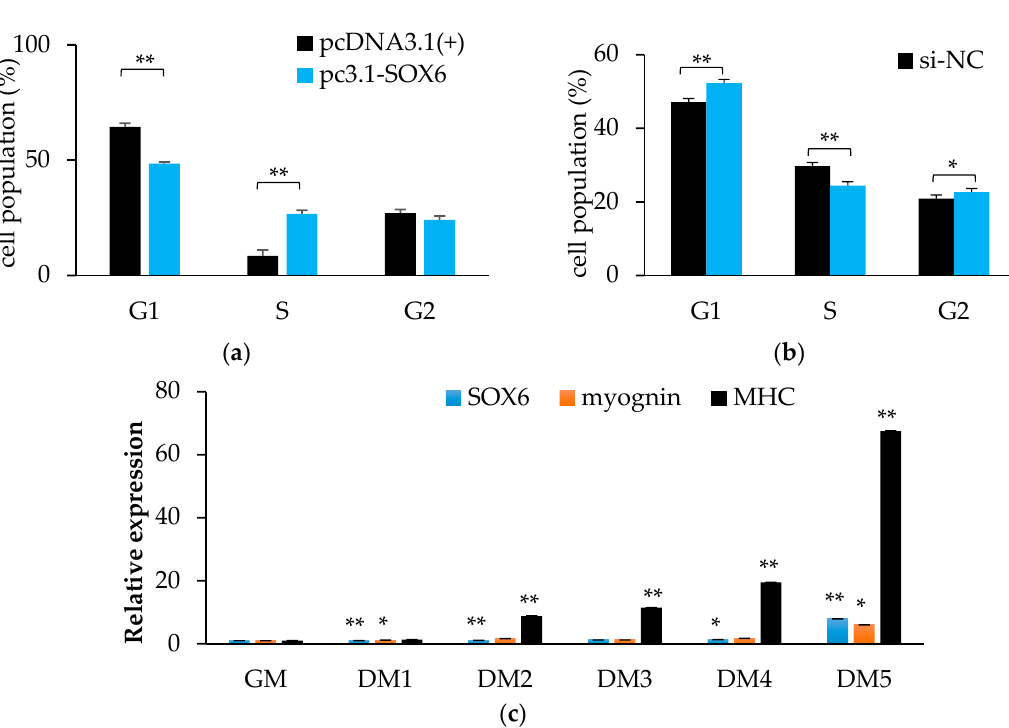
Figure 8. Chicken SOX6 promotes cell proliferation and differentiation. ( a , b ) The cell population of cell cycles after overexpressing or interference with SOX6, respectively. ( c ) The expression levels of SOX6, myognin and MHC in QM7 during differentiation medium from one to five days (DM1–5). Significance: *, ** indicate p < 0.05 and p < 0.01 vs. general medium (GM), respectively.